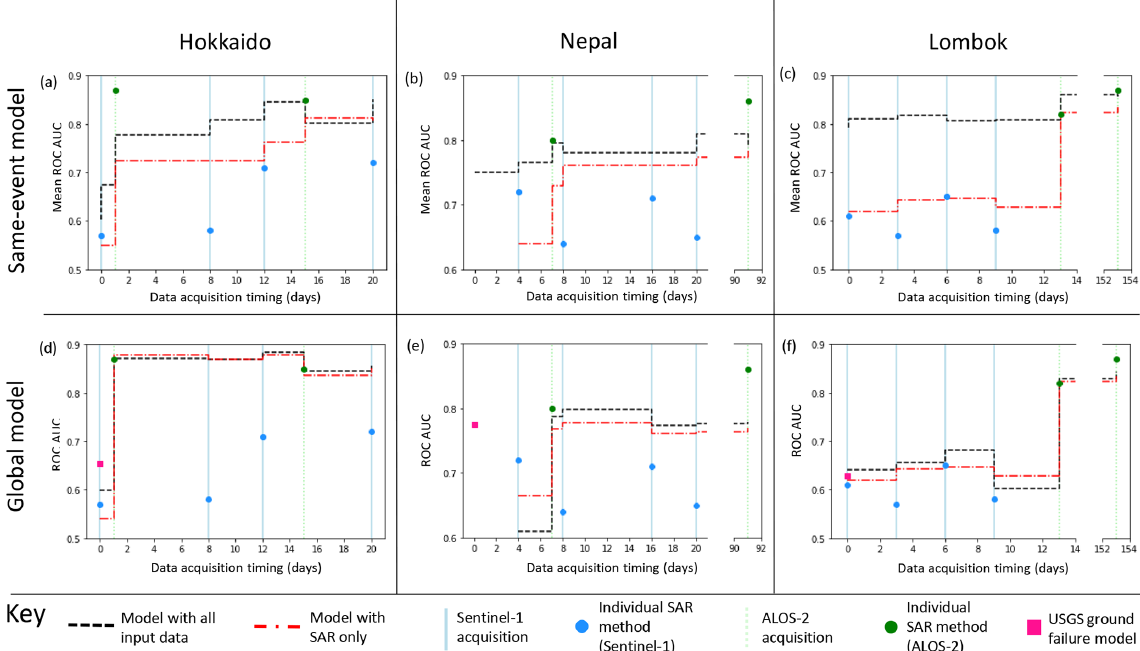
Figure 5. A comparison between the performance in terms of ROC AUC of individual SAR methods (blue and green circles), the model of Nowicki Jessee et al. (2018) (pink square), a combined model using all input data listed in Sect. 2.3 (black line) and a model using only SAR data (both Sentinel-1 and ALOS-2, red line).